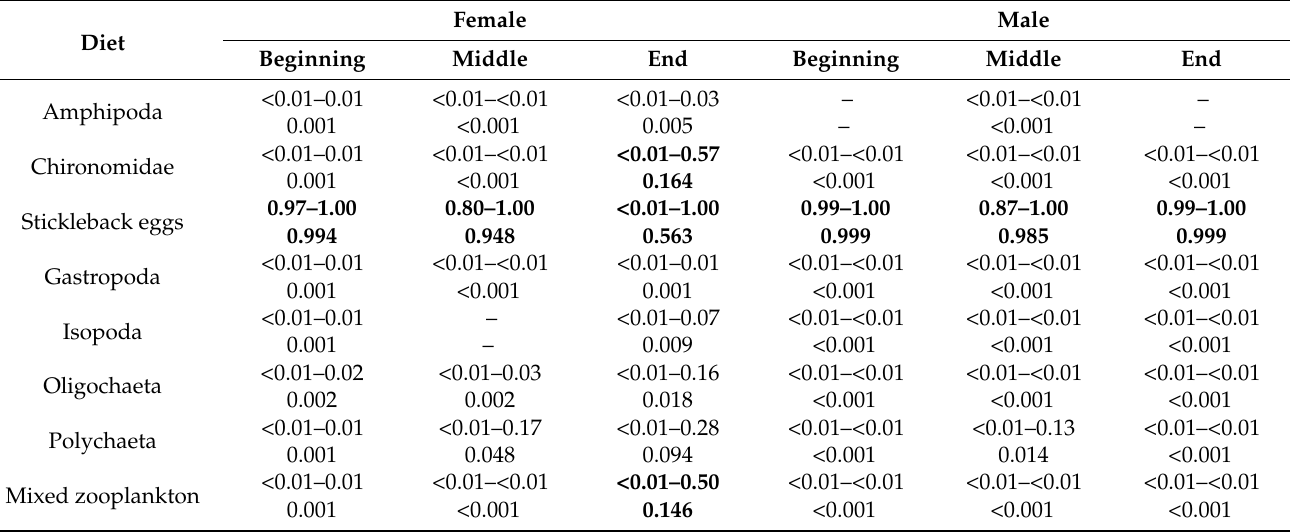
Table 5. Predicted diet composition of threespine stickleback (%) in different stages of spawning period based on Bayesian mixing model performed with MixSIAR package in R. Range from 2.5% and 97.5% quantiles is in numerator, mean value is in denominator. Prey items with the highest contribution are marked in